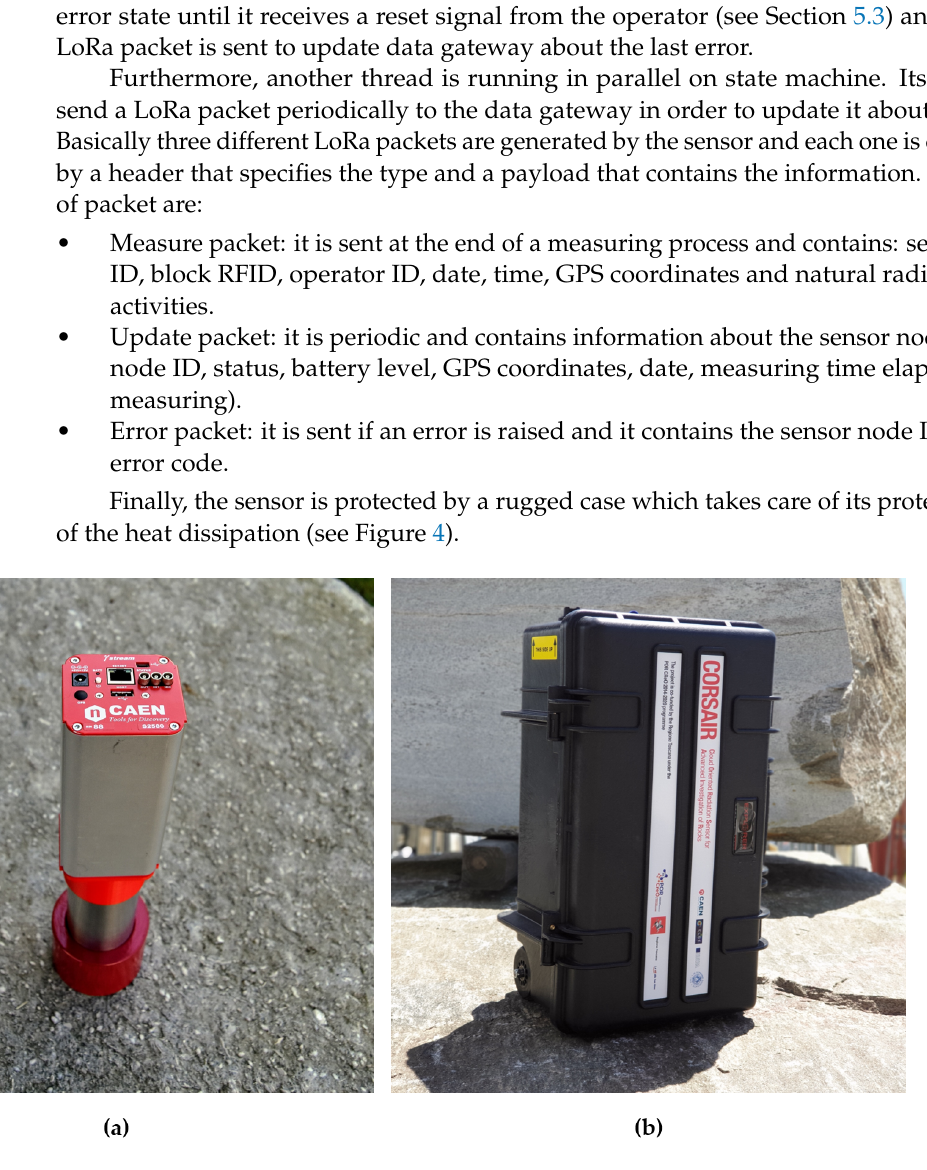
Figure 4. ( a ) Photo of the shielded CeBr 3 detector coupled to the PMT and to CAEN GammaStream. ( b ) Photo of the CORSAIR sensor node enveloped by its shock-proof